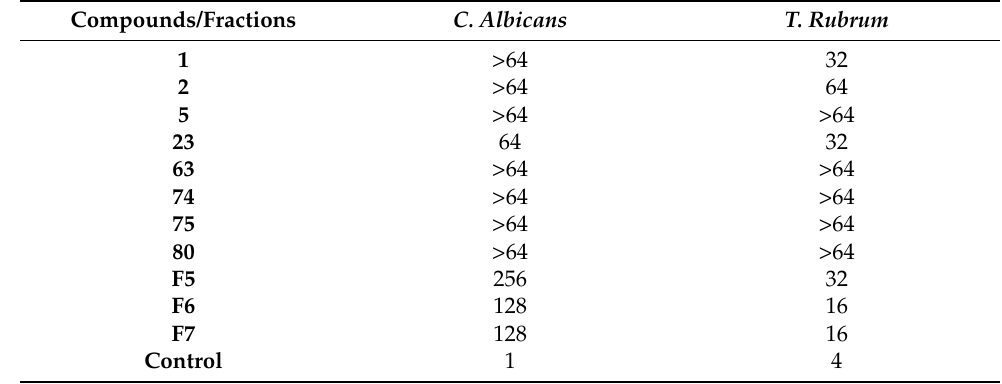
Table 1. Minimal inhibitory concentrations in µ g.mL − 1 of isolated compounds against C. albicans and T. rubrum . Fluconazol was used as positive